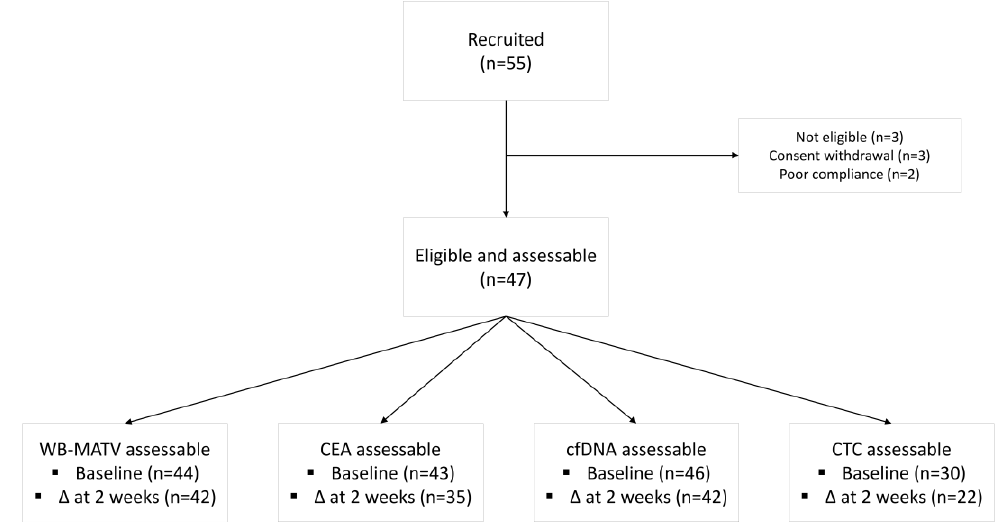
Figure 1. Study flow diagram. Abbreviations: WB-MATV, whole body metabolically active tumor volume; CEA, carcinoembryonic antigen; cfDNA, circulating-free DNA; CTC, circulating tumor cell; Δ, delta.